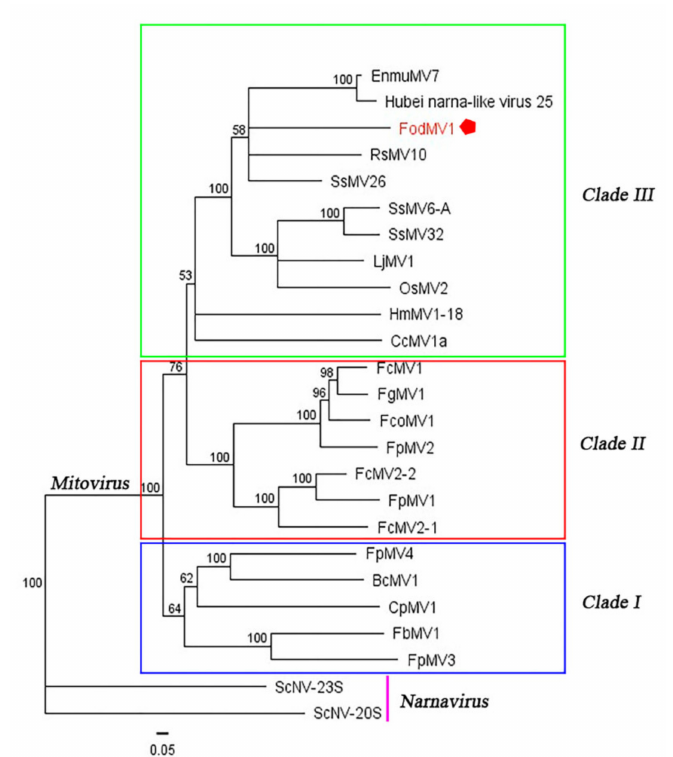
Figure 5. Phylogenetic analysis of FodMV1 based on the aa sequence of the RdRp. Neighbor-joining consensus tree of FodMV1 and a number of selected mitoviruses (See Table 2) based on the full length aa sequence of the viral RdRp. Color boxes indicate the di ff erent clades obtained. The phylogenetic tree was constructed using Tree View of Geneious 8.1.5 package (Biomatters), and generated by the neighbor-joining method with 1000 bootstrap